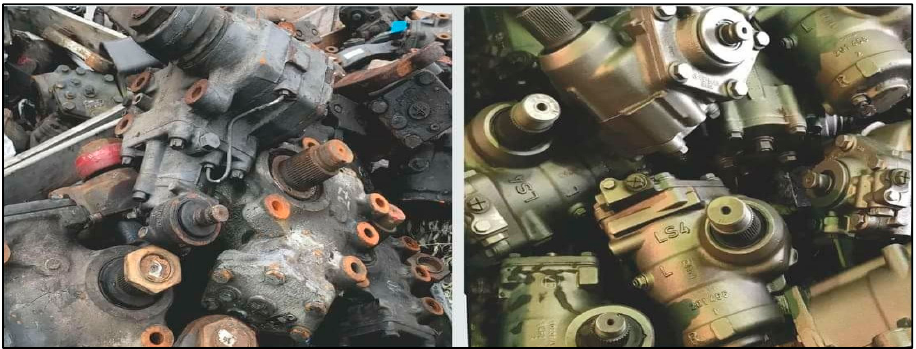
Figure 1. An example of core and remanufactured product (Courtesy: PSS, Norwich, England, UK).